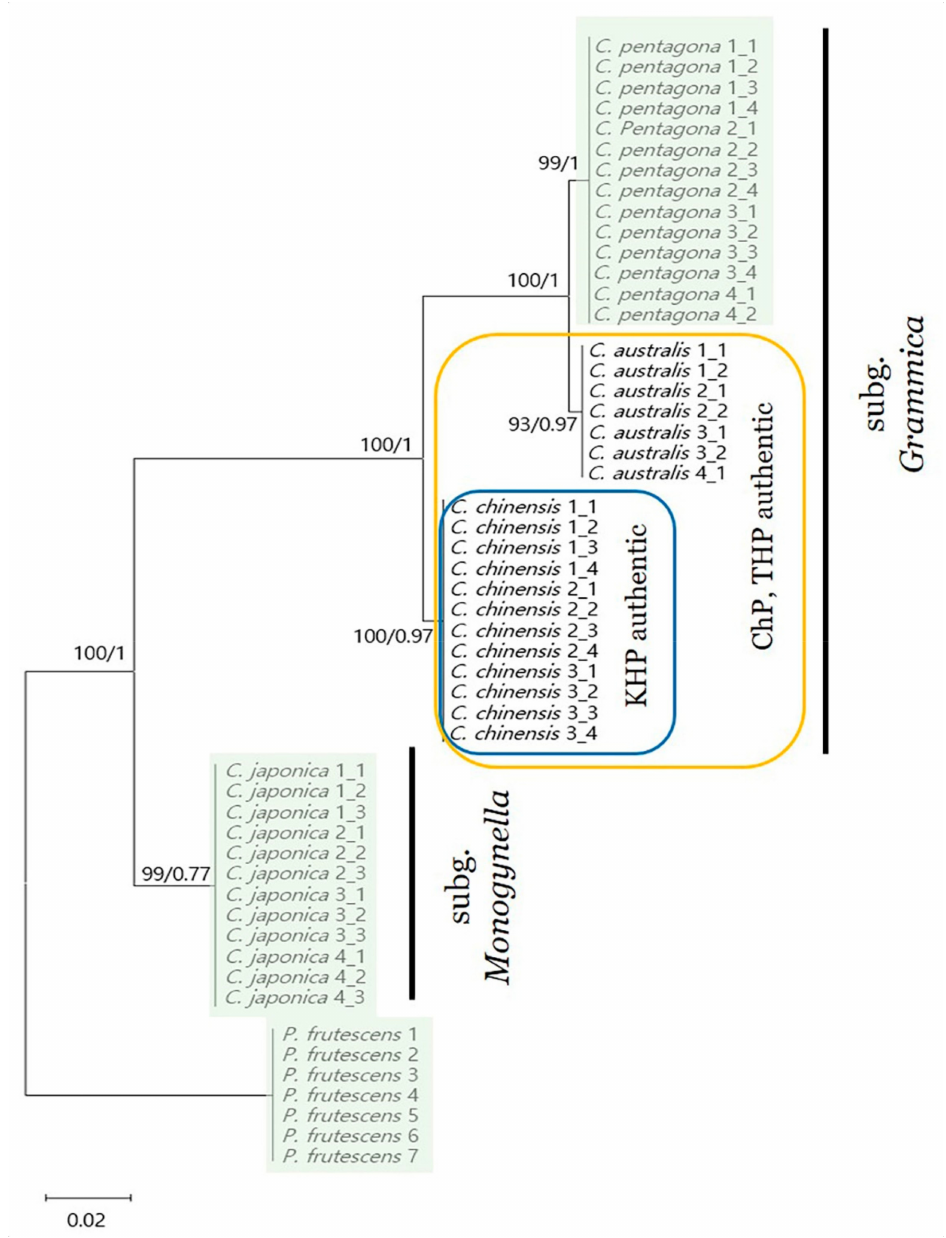
Figure 6. Phylogenetic analysis of five species using the maximum likelihood (ML) and Bayesian inference (BI) methods with Cuscuta rbcL sequences and Perilla frutescens rbcL sequences downloaded from Genbank as outgroups (1: FJ513160; 2: KP644065; 3: KT220688; 4: KX397889; 5: MG223657; 6: MG224544; 7: KY624981). ML topology is shown with bootstrap (BS) values (%) and BI posterior probability (PP) values at each node. ChP, Pharmacopoeia of the China; KHP, Korean Herbal Pharmacopoeia; THP, Taiwan Herbal Pharmacopeia. Green shaded species indicate adulterants of